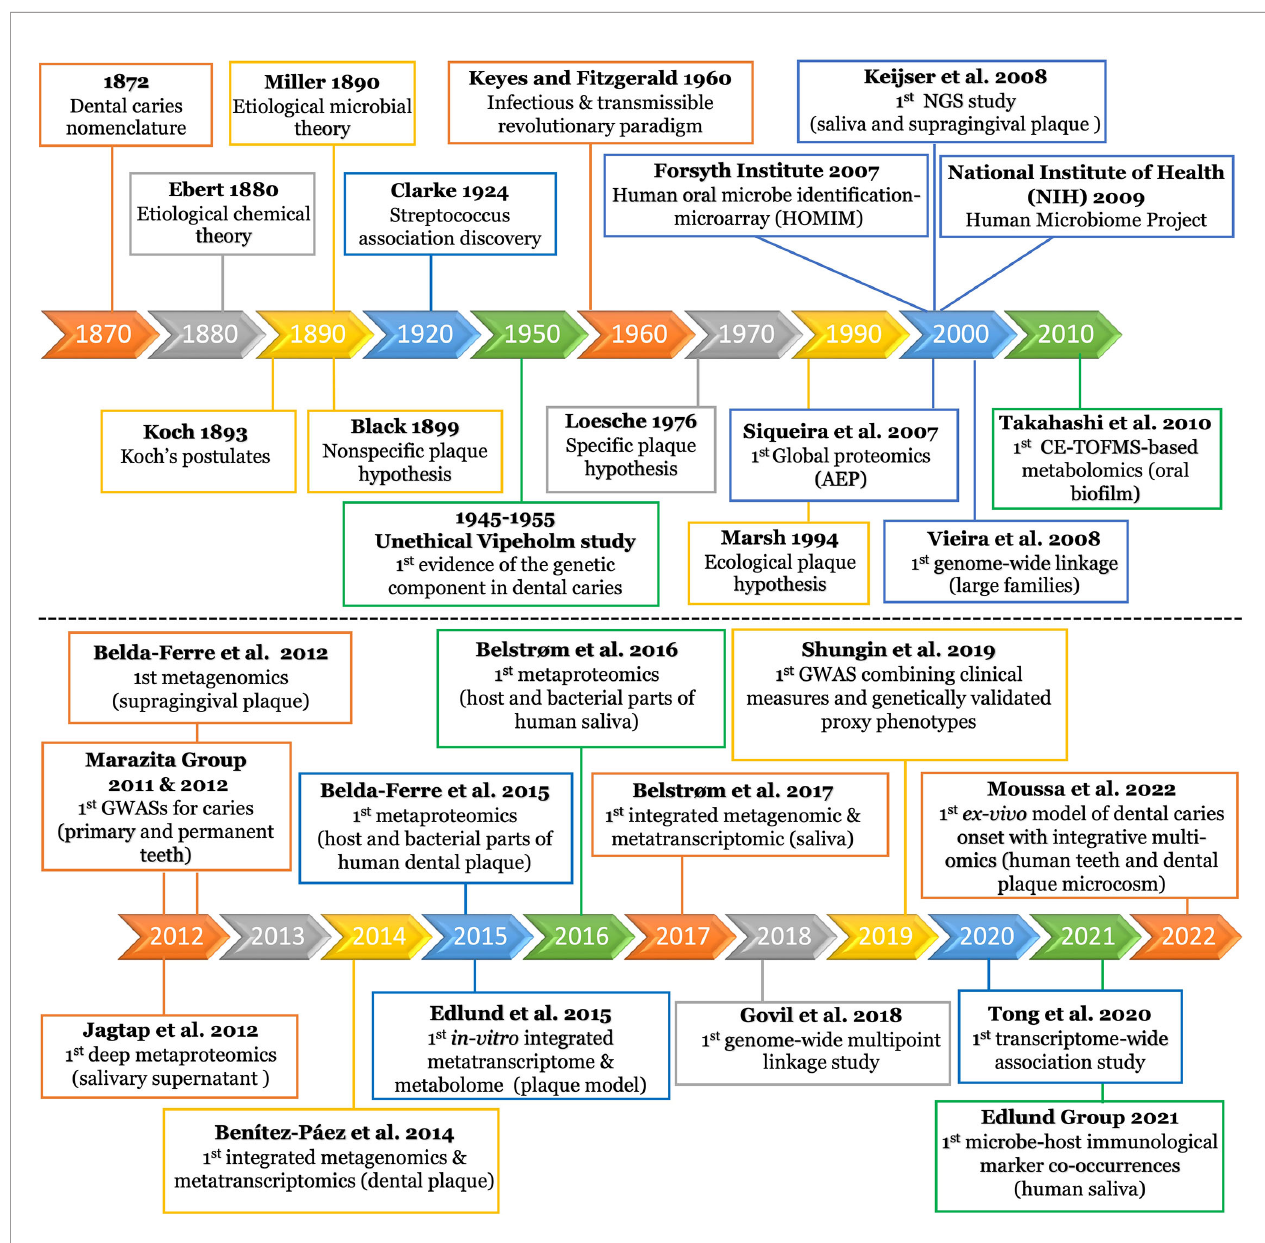
FIGURE 2 | Timeline of milestones in dental caries research since emergence. The top panel displays the research milestones from the beginning of the fi eld until 2010. The timeline displays selected intervals guided by the sporadic distribution of the earlier research events. The bottom panel displays the research events from 2010 to the present, using a one year interval. The details of each research event is displayed in the corresponding box of the timeline interval. AEP, acquired enamel pellicle; NGS, next generation sequencing; CE-TOFMS, capillary electrophoresis-time of fl ight mass spectrometer; GWAS, genome-wide association